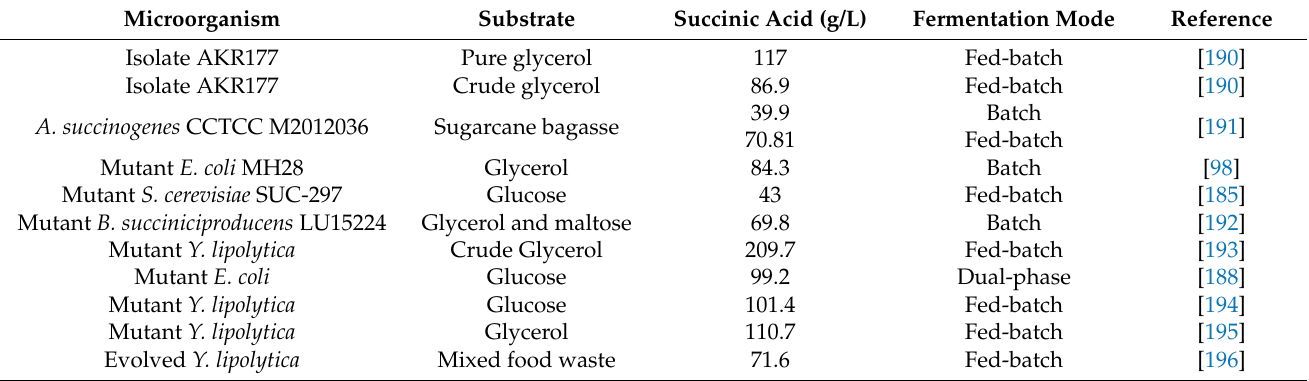
Table 6. Succinic acid production with different substrates, microorganisms, and fermentation